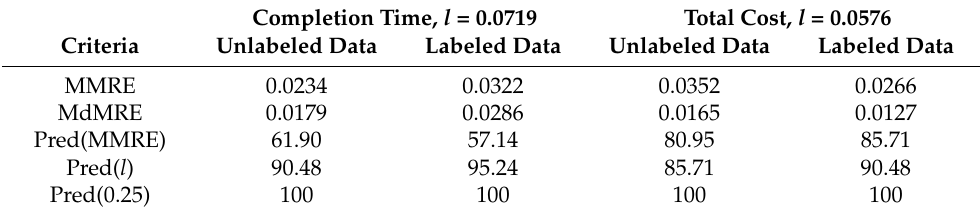
Table 7. Comparison of DT evaluation